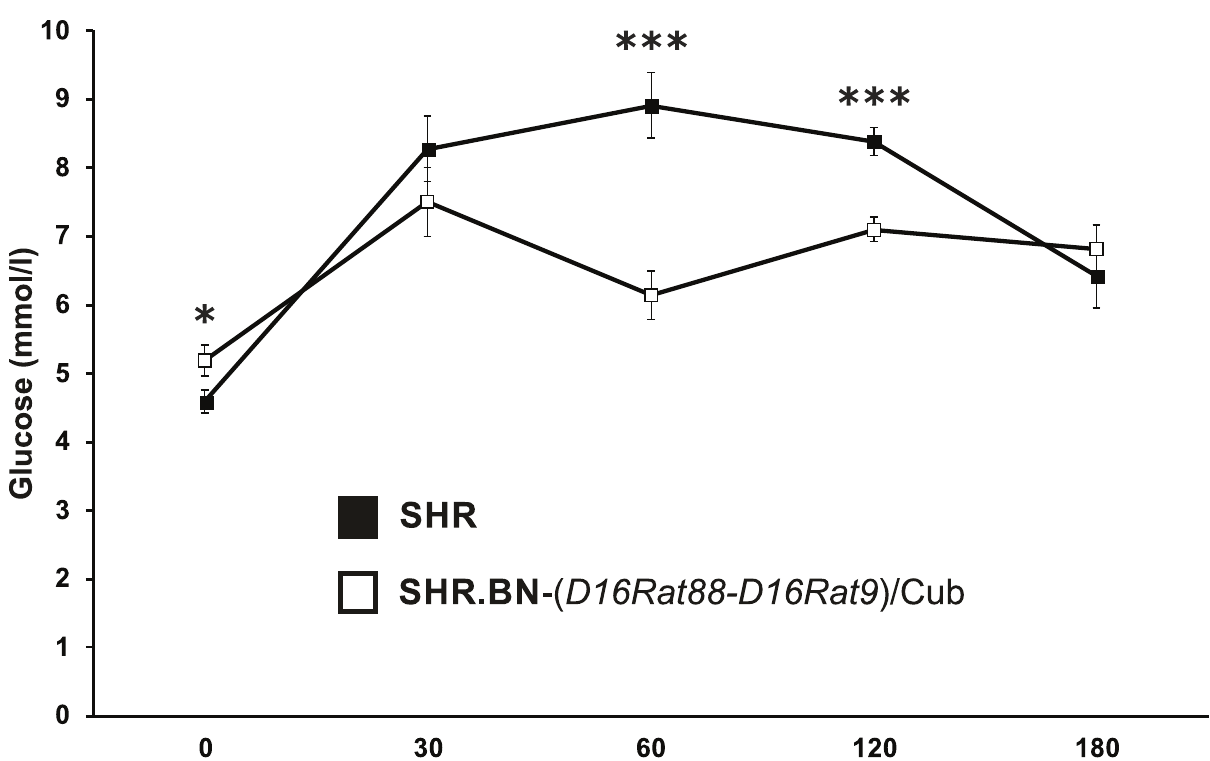
Fig 2. The oral glucose tolerance test in SHR and SHR.BN-( D16Rat88-D16Rat9 )/Cub strains. Glycemic time courses for adult male SHR (black squares) and SHR.BN-( D16Rat88-D16Rat9 )/Cub (white squares) rats fed a standard diet. * P < 0.05; *** P <